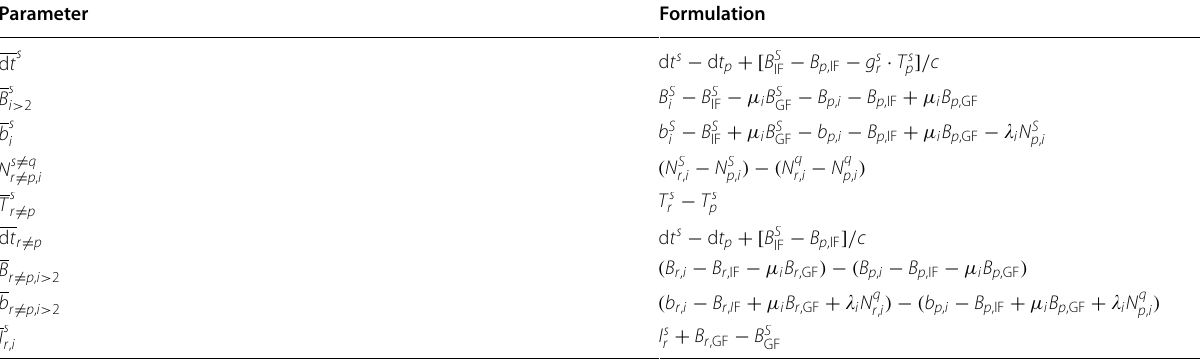
Table 2 The estimable parameters of un-differenced and un-combined PPP–RTK and corresponding formulations Parameter